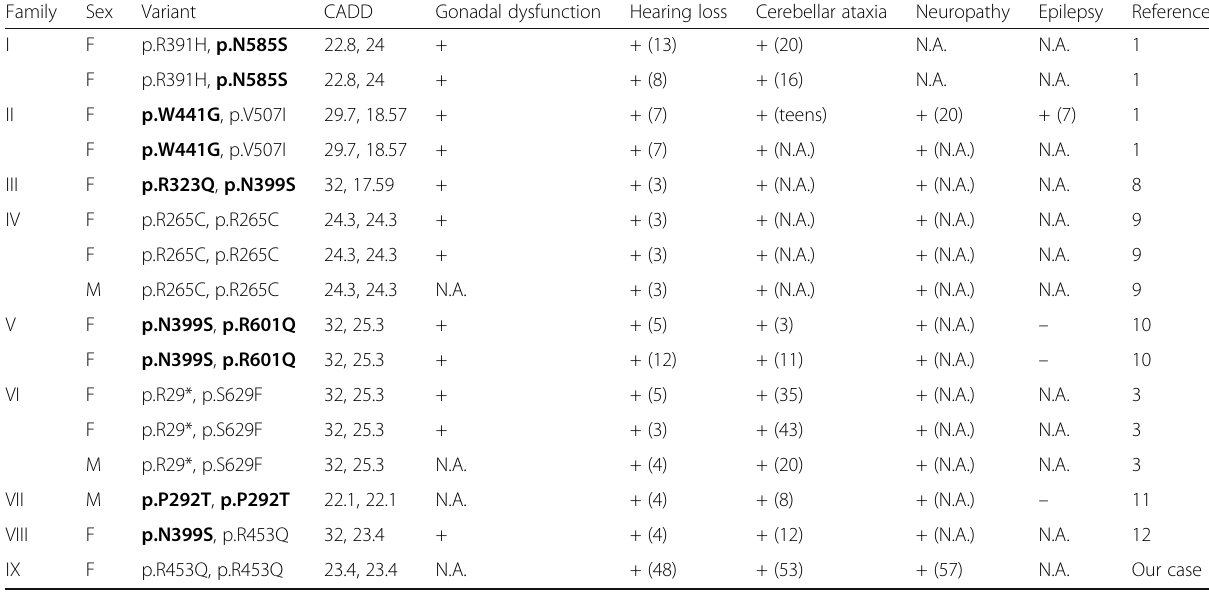
Table 1 Genetic and clinical features in PRLTS5